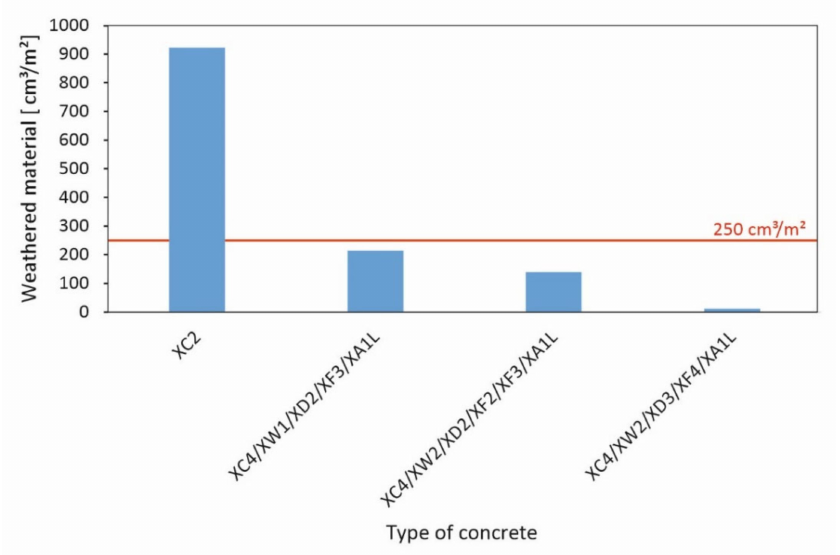
Figure 9. Results of the freeze–thaw tests according to [15] with 250 cm 3 /m 2